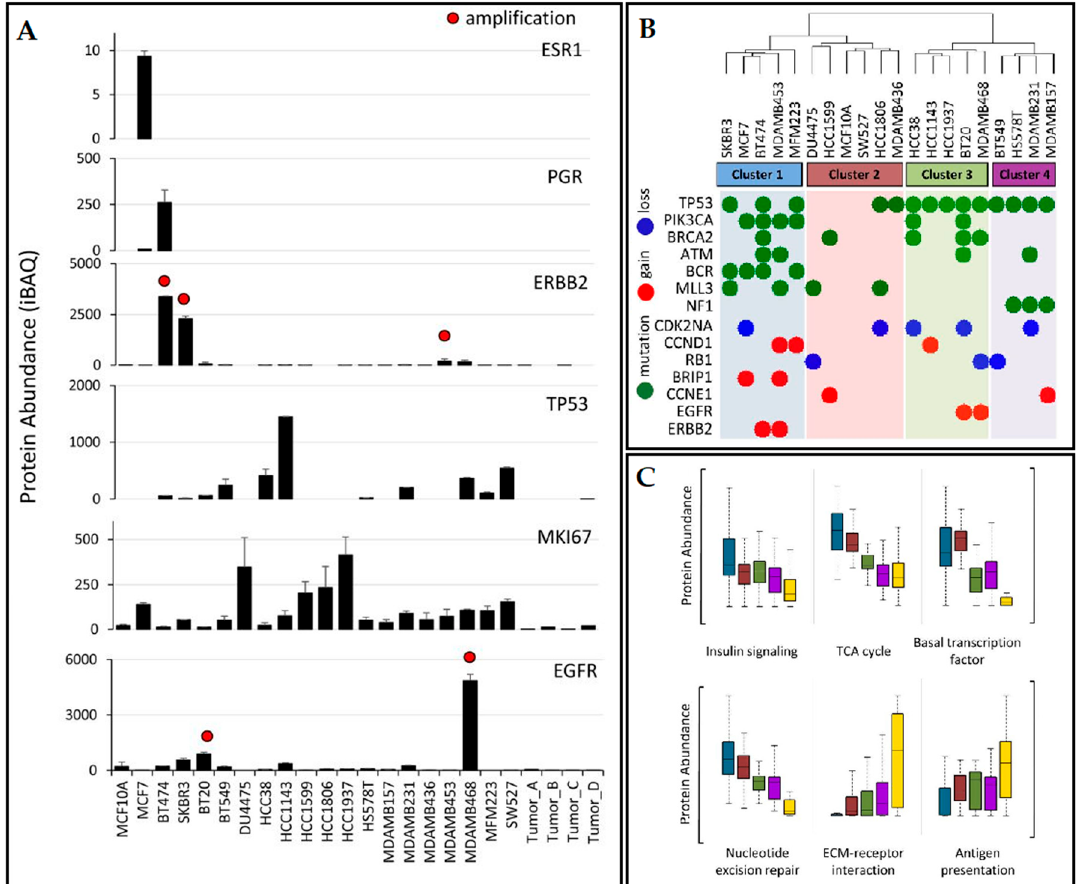
Figure 2. ( A ) Clinical biomarkers quantification in the tested cell lines; ( B ) hierarchical clustering of protein expression profiles with genetic irregularities superimposed; ( C ) protein abundances dissemination within clusters for indicated biological processes; cluster membership is indicated by the same colors used in ( B ), with tumor samples indicated in yellow. ESR1, estrogen receptor; PGR, progesterone receptor; ERBB2, human epidermal growth factor receptor-2; TP53, tumor protein p53; MKI67, Ki-67 antigen; EGFR, human epidermal growth factor receptor. Absolute protein abundance was calculated using iBAQ. Error bars represent standard deviation. Red dots indicate > 7 gene copy-number amplification. (Partially reproduced with permission from ref. [48]).